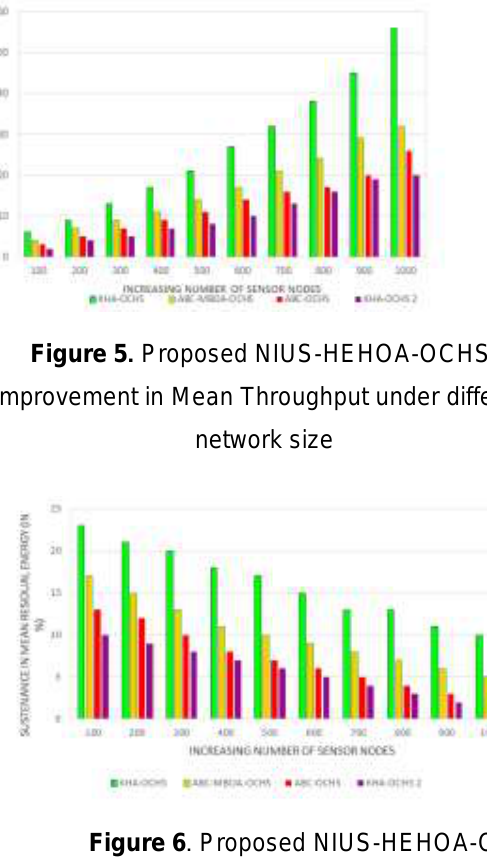
Figure 6 . Proposed NIUS-HEHOA-OCHS: Sustenance in Mean Resisual Energy under different